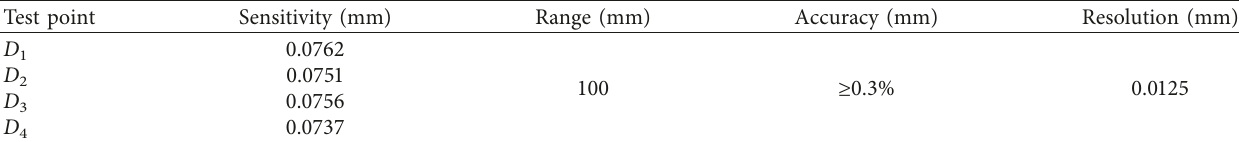
Table 3: Parameters of the displacement meter.